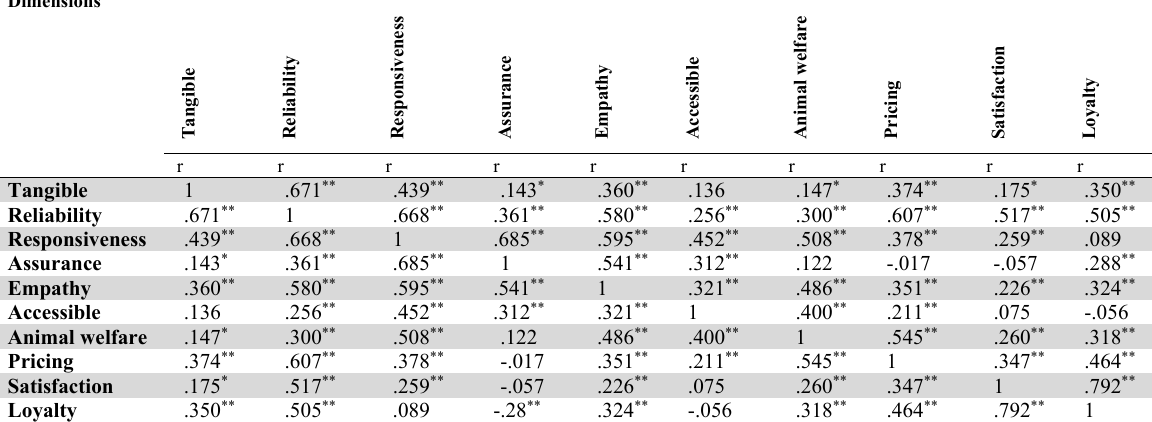
Satisfaction Loyalty